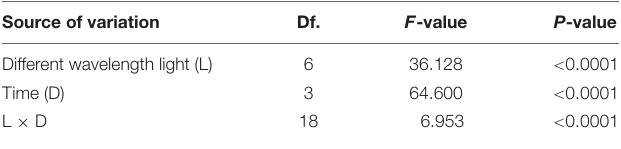
TABLE 3 | Two-way ANOVA of effects of different wavelength light, treatment time and their interaction on seed germination of S. ferganica. Source of